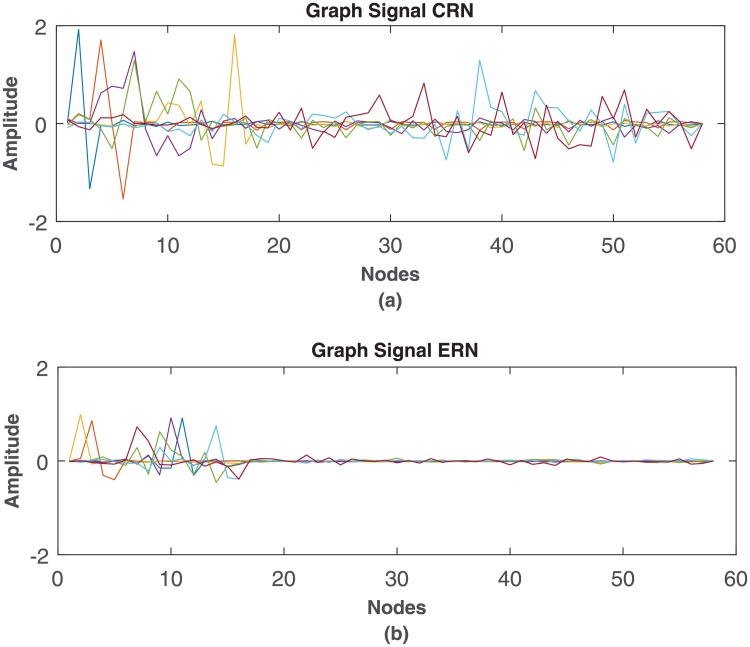
Graph signal representation.The first six signals obtained from graph-to-signal transformation of a. CRN networks; b. ERN networks.